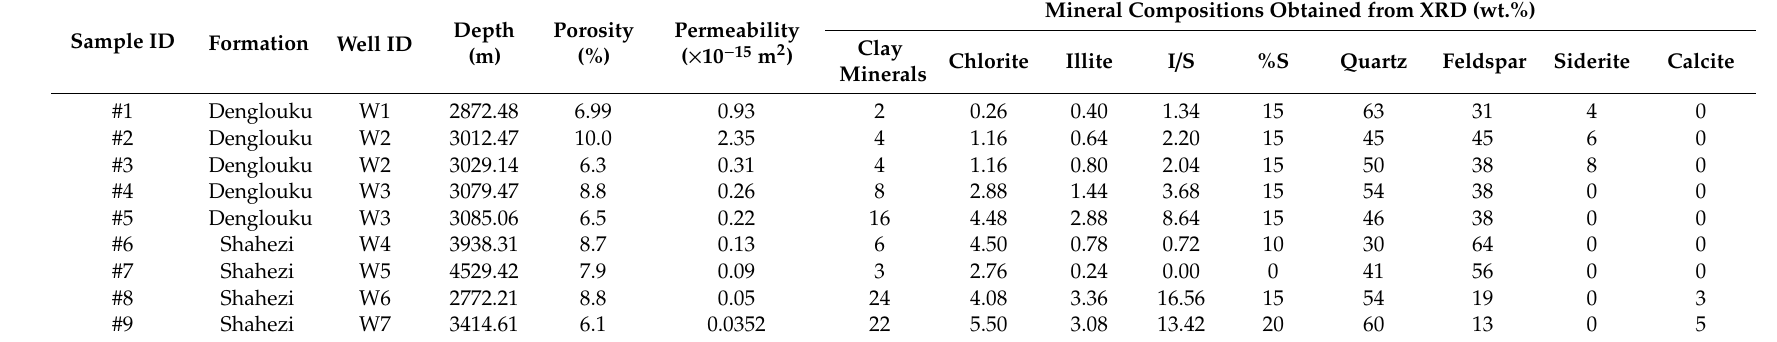
Table 1. Petrophysical properties and mineral compositions of nine tight rock samples in the Xujiaweizi